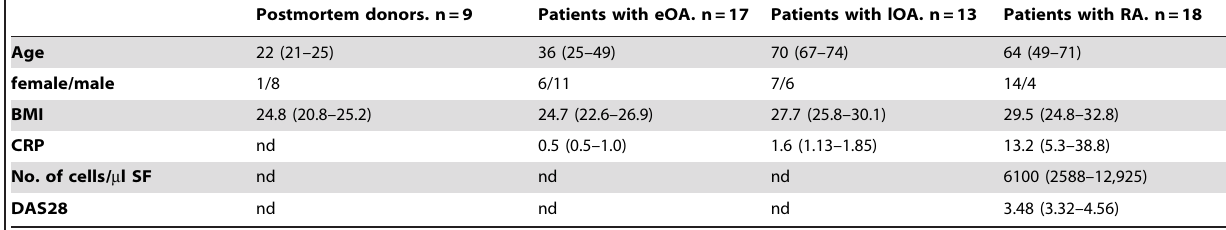
Postmortem donors. n=9 Patients with eOA. n=17 Patients with lOA. n=13 Patients with RA. n=18